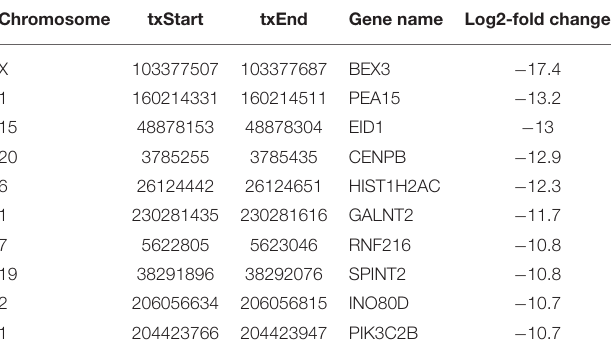
TABLE 4 | Top 10 down methylated m6A